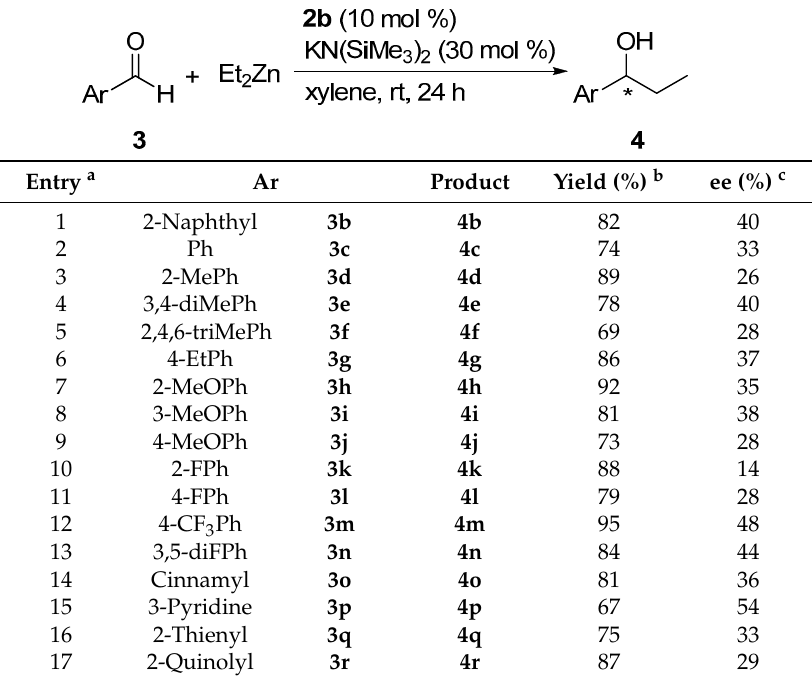
Table 2. Scope of